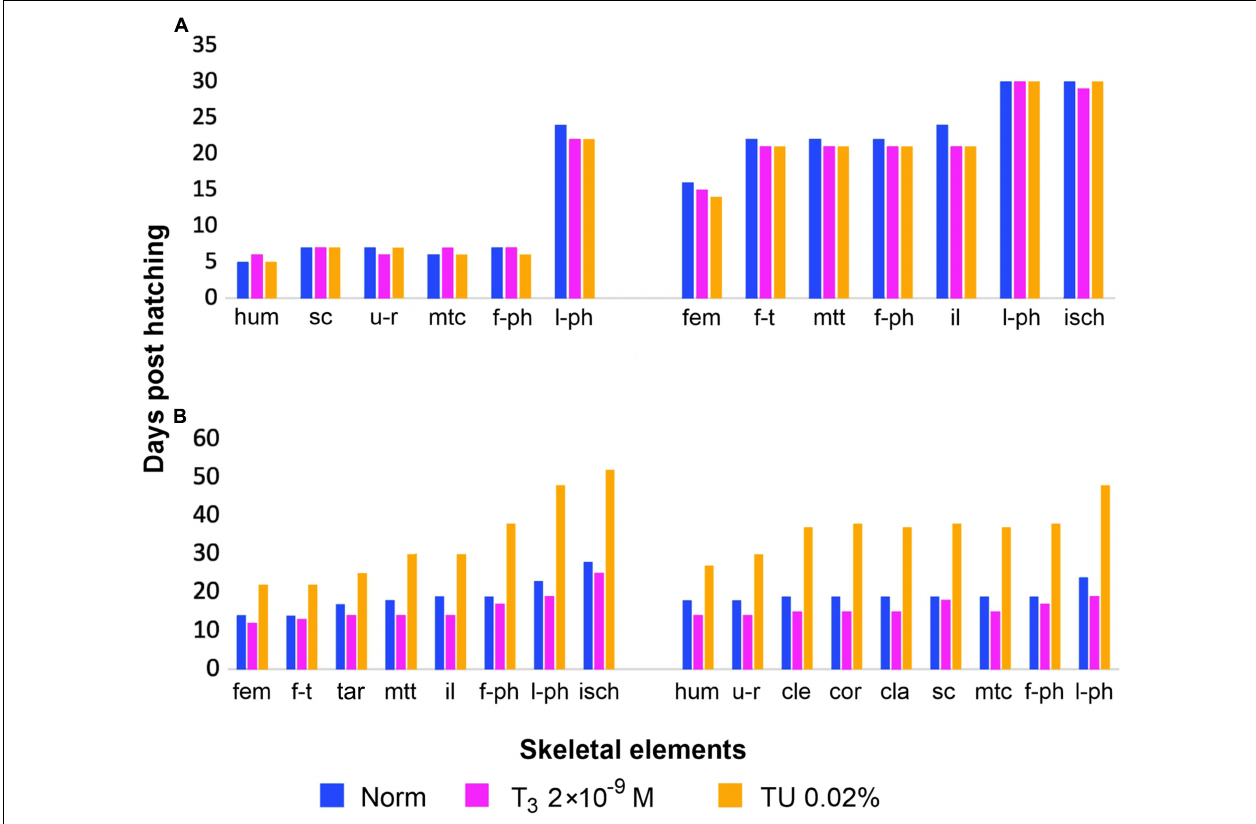
FIGURE 9 | Timing of appendicular bones development (earliest appearance) under same experimental hormonal regimes (in norm, under T 3 and TU-treatment), (A) in Lissotriton vulgaris (after Smirnov and Vassilieva, 2003) and (B) in Bombina variegata (this study). Abbreviations: cla, clavicle; cle, cleithrum; cor, coracoid; fem, femur; f-ph, first phalanges; f-t, fibula and tibia; tar, tarsals; hum, humerus; il, ilium; isch, ischium; l-ph, last phalanges; mtc, metacarpals; mtt, metatarsals; sc, scapula; u-r, ulna and